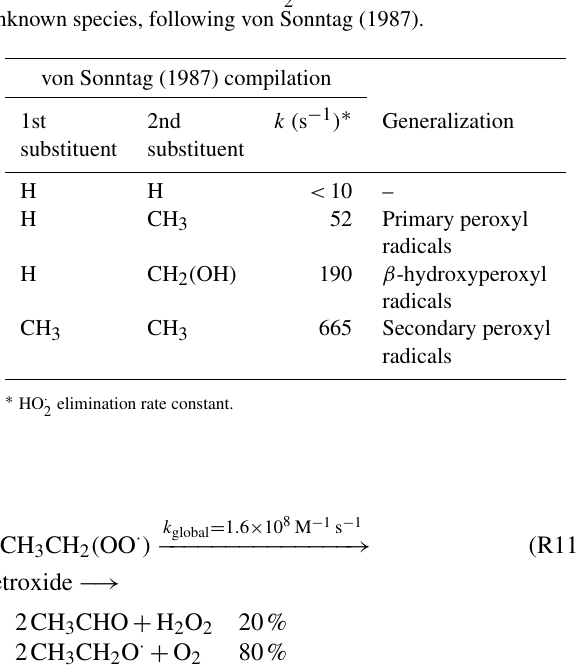
elimination rate constants for 2